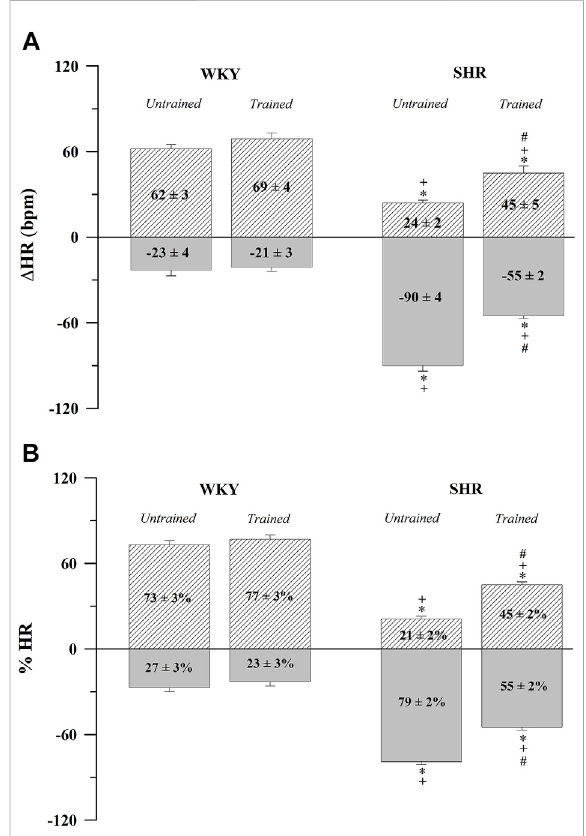
FIGURE 1 Absolute (A) and normalized (B) tonic autonomic cardiac responses to atropine (positive values) or propranolol (negative values) in trained ( N = 07) and untrained ( N = 07) normotensive Wistar Kyoto (WKY) and spontaneously hypertensive rats (SHR). Values are expressed as means ± standard error of the mean. * p < 0.05 vs. WKY untrained group; + p < 0.05 vs. WKY trained group; # p < 0.05 vs. SHR untrained